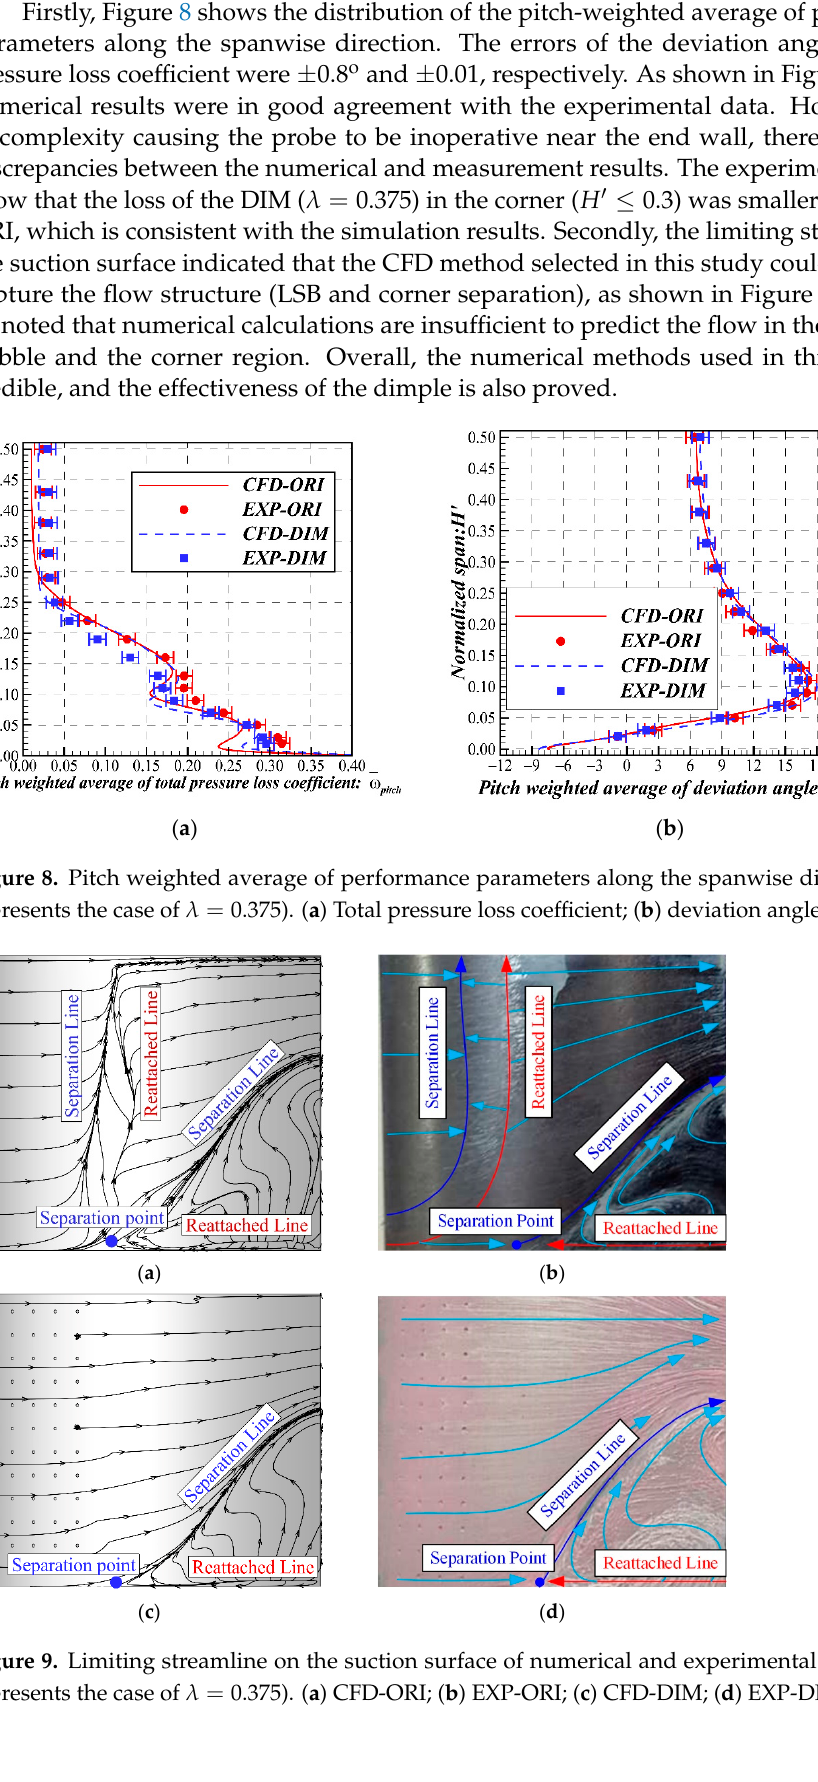
Figure 7. Variation of inlet normalized total pressure along height.